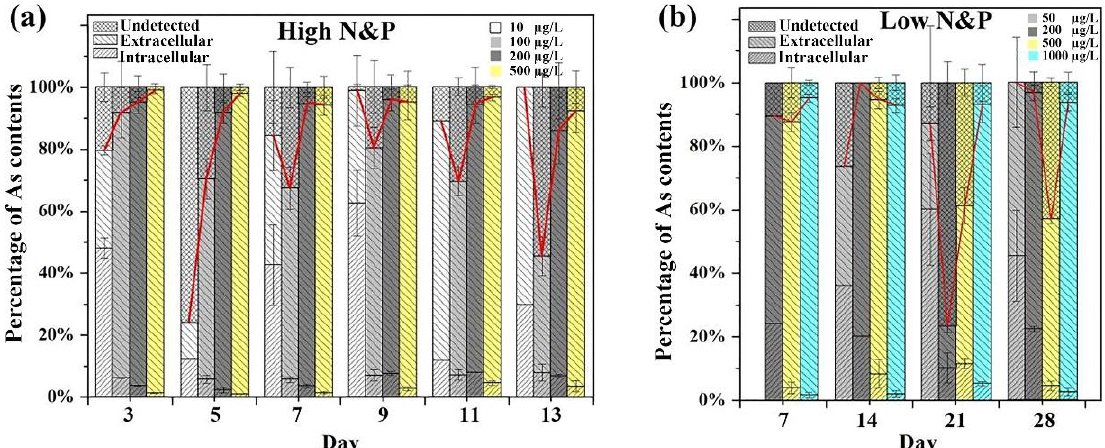
Figure 3. The percentage of detected intracellular and extracellular As contents, and undetected intracellular and extracellular As content in the total added iAs(V) concentration varied with incubation time that exposed different ambient iAs(V) concentrations in the high ( a ) and the low ( b ) nutrient sets. The variant pattern of total detected intracellular and extracellular arsenic contents with rising iAs(V) concentrations was connected by red lines for each incubation day.